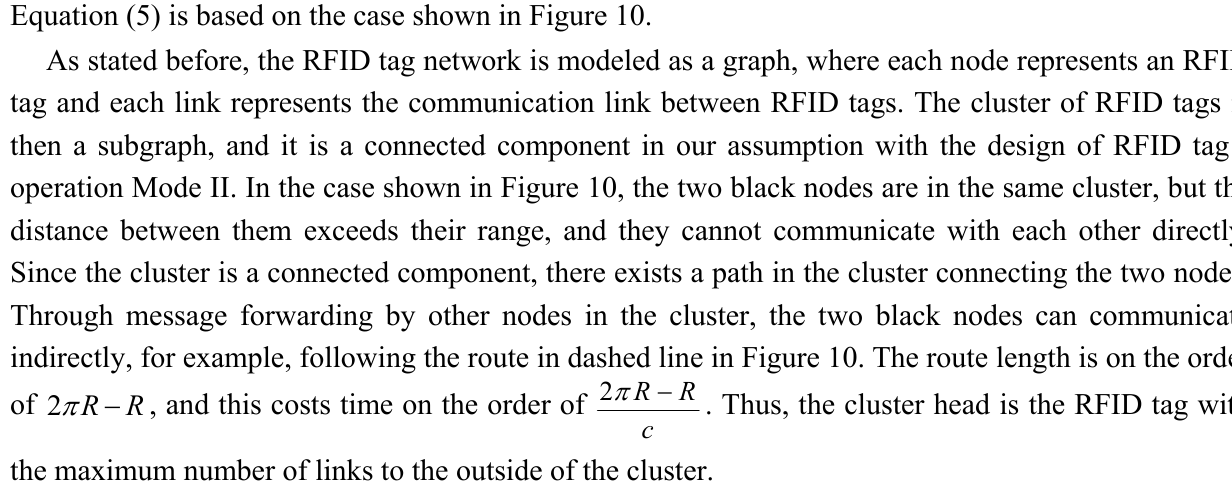
Figure 10. Case for maximum